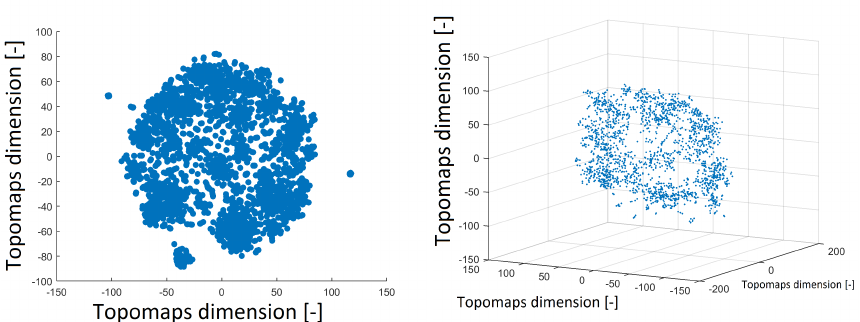
Figure 3. Reduced space of topomaps after using the t-SNE method to 2D space ( left ). Reduced space of topomaps after the using t-SNE method to 3D space ( right ). In both examples, a perplexity of 30 was